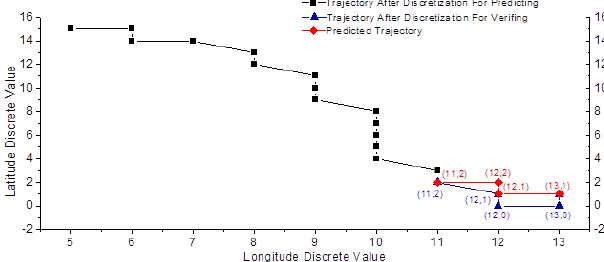
Fig. 9. Minsup and the correct rate when minconf =